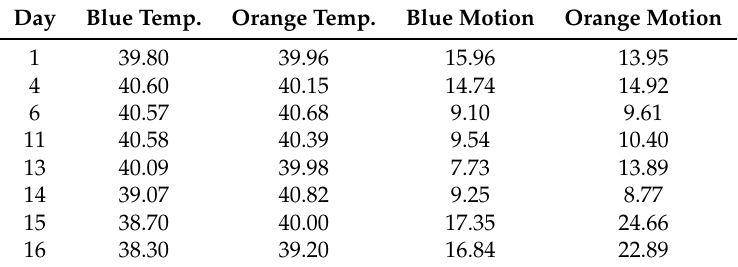
Table 1. Temperature and motion scores in E1. Temperature ( ◦ C) and daily motion ( × 1000 pix/frame) on sampling days for each animal (both infected with ASFV Arm07). Blue